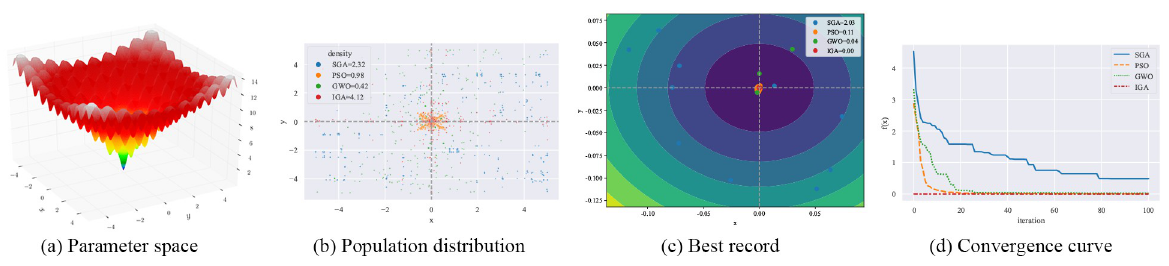
Fig 4. Qualitative results for the F13 function. (a) Parameter space. (b) Population distribution. (c) Best record. (d) Convergence curve.